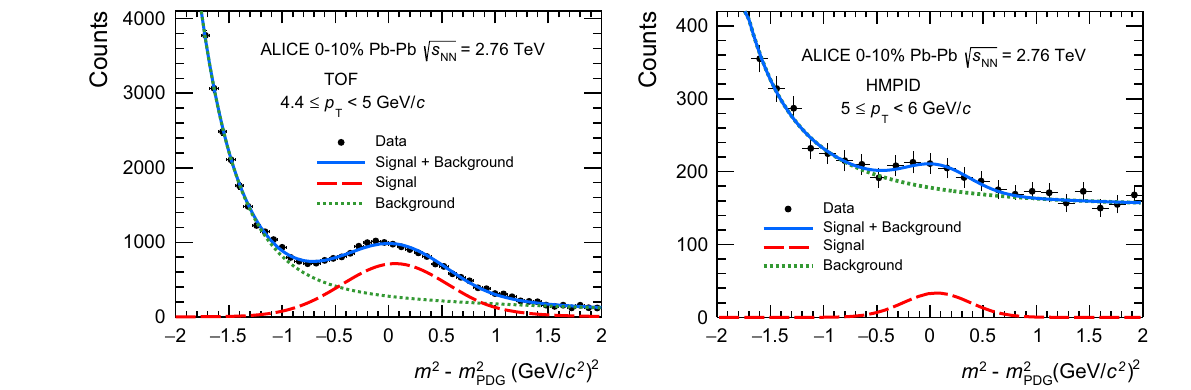
of deuteron as reported in [28]. Solid lines represent the total fit (signal plus background), dotted lines correspond to background and dashed lines to deuterons